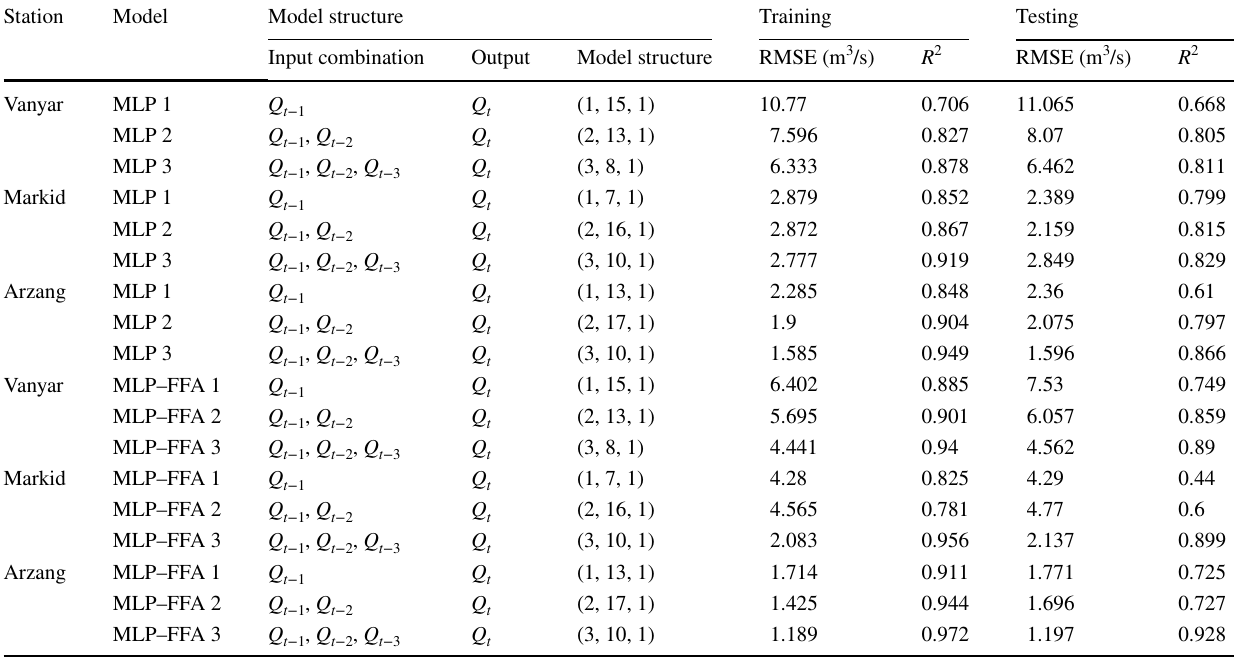
Table 2 Statistical analysis of simulated values with ANN–MLP and MLP–FFA models Station Model Model